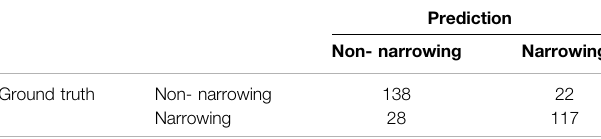
FIGURE2| Theeffect ofthenumber ofvariablestried ateach split(Mtry) on the performance of RF using the OOB estimate of error (%).